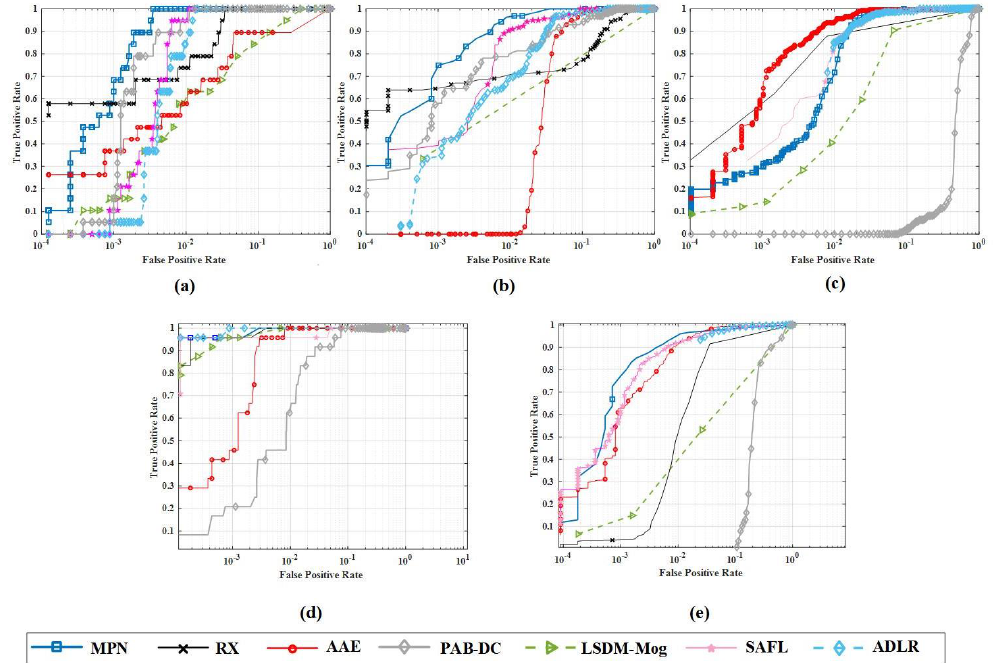
Figure 4. The ROC curves comparison of different methods for ( a ) HYDICE, ( b ) ABU-urban1, ( c ) ABU-urban2, ( d ) Grand Island, ( e ) EI Segundo models . When the curve is higher, the detection performance is better.